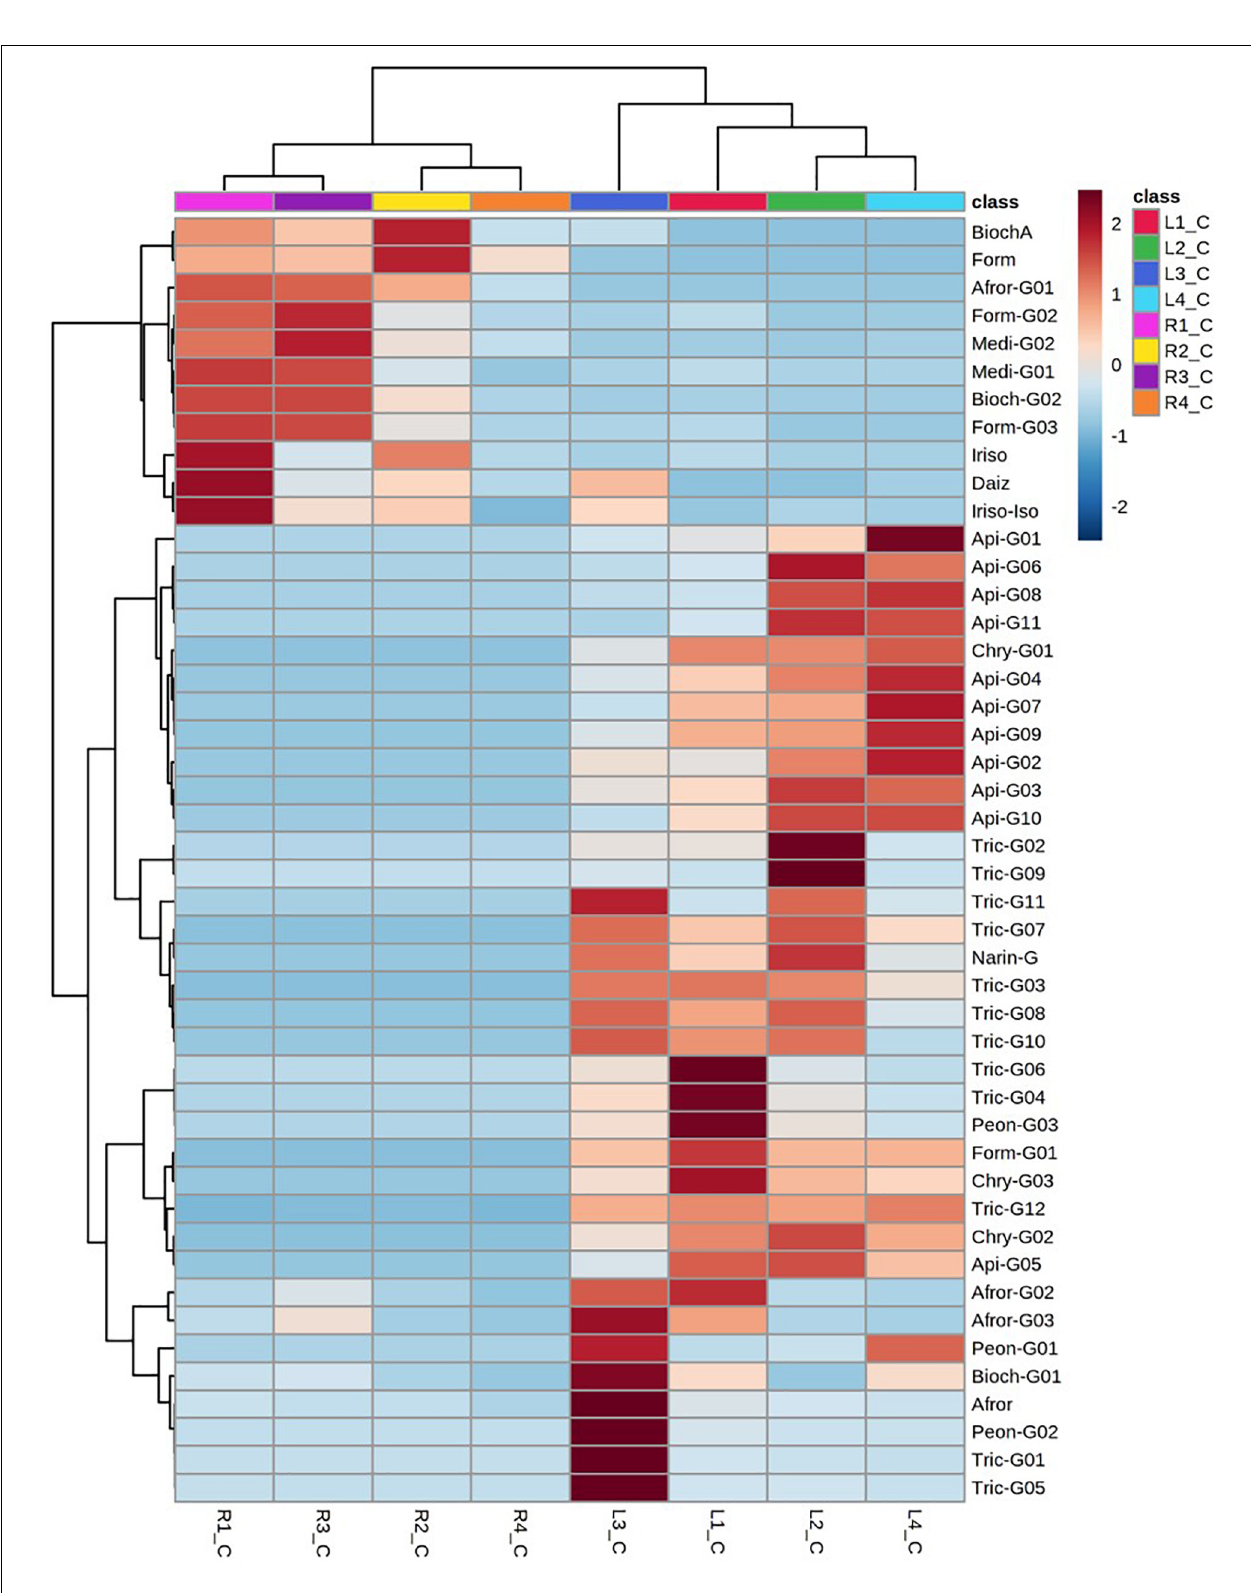
Frontiers in Plant Science |